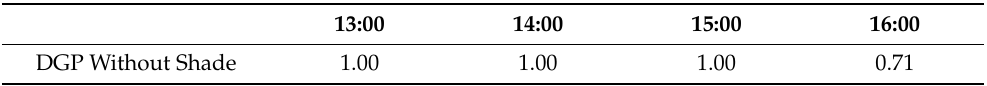
Table 4. DGP on December 20 without shading